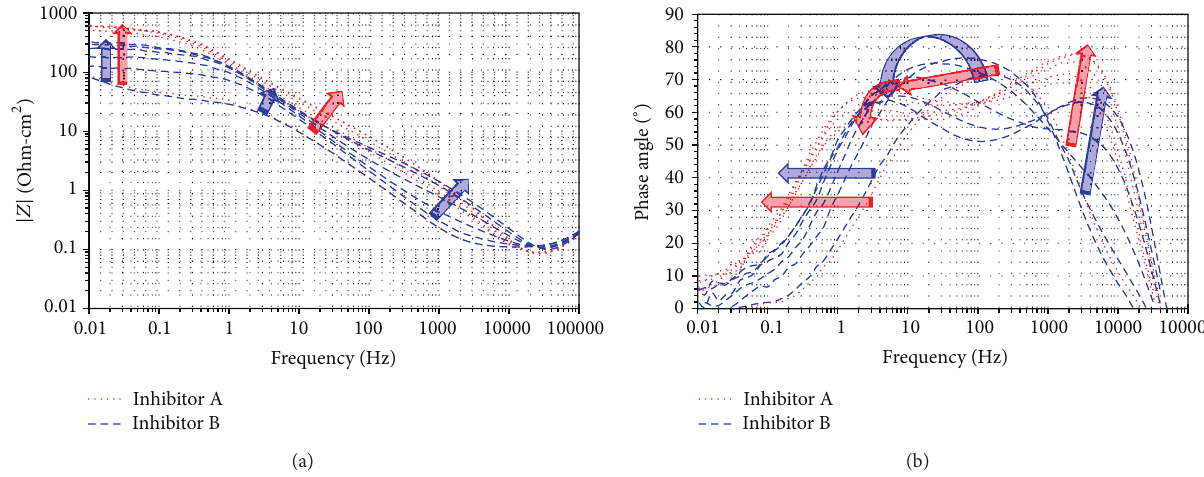
Figure 4: Bode plots in the (a) impedance module and (b) phase angle format for carbon steel in the CO 2 -saturated (3% NaCl + diesel) solution with inhibitors A and B at 50 ∘